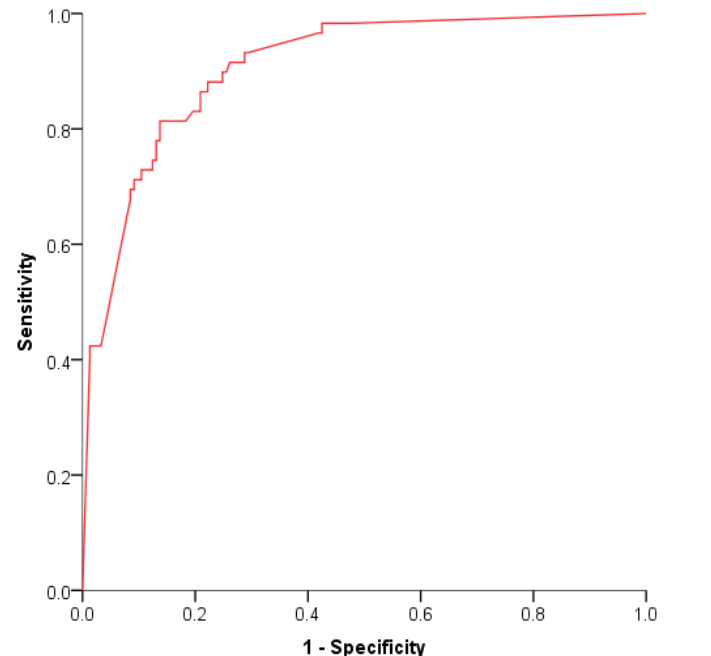
Figure 3. ROC curve for the combination of M2-PK and Hb Table 3. Evaluation of the accuracy of the evaluated strategies for significant diagnosis of CRC. Biomarkers Parameters